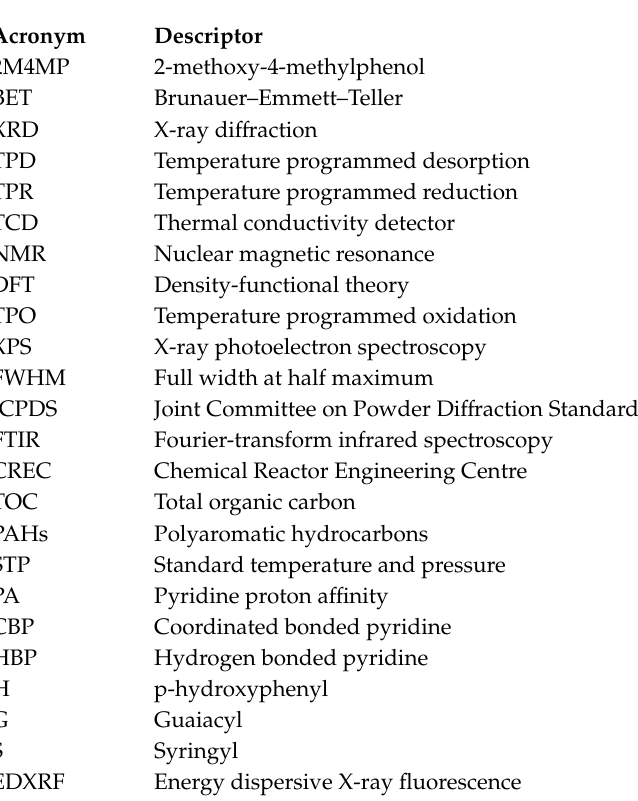
Table S1: Typical Ash Chemical Composition Obtained during Gasification Runs of Di ff erent Biomass Using a Downdraft Gasifier Operated in Costa Rica, using